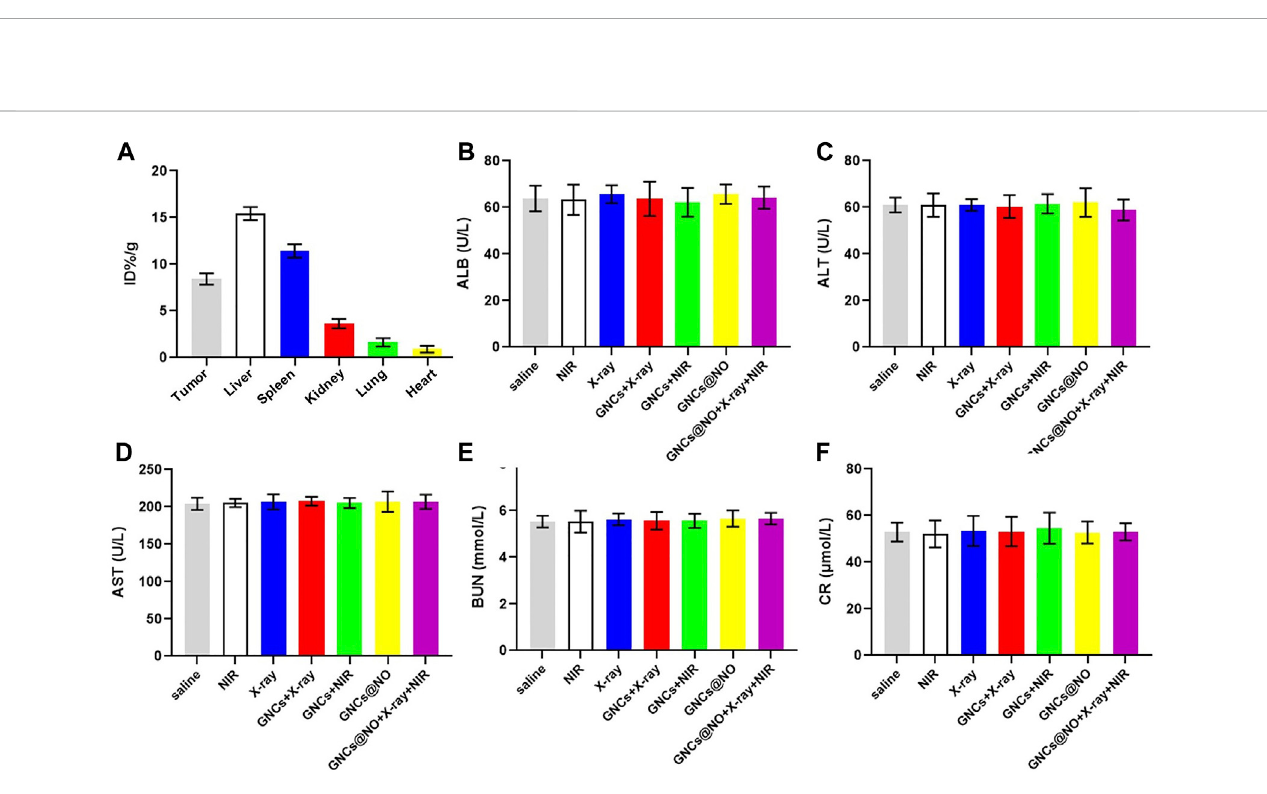
FIGURE 5 Biosafety evaluation. (A) Biodistribution of GNCs@NO. (B – F) Serum biochemistry indexes. Levels of ALB (B) , ALT (C) , AST (D) , BUN (E) , and CRE (F) . The values represent mean values ±SD, n =